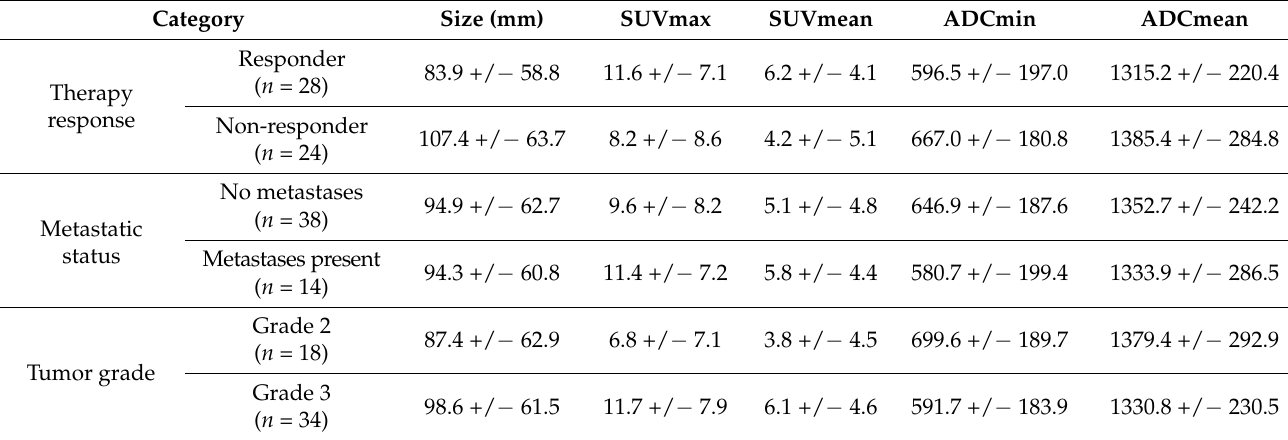
Table 3. Results of quantitative image analysis (mean values +/ − standard deviation) of the 18F-FDG PET/MRI-derived quantitative imaging parameters, in dependence of histopathological treatment response, metastatic status and tumor grade.